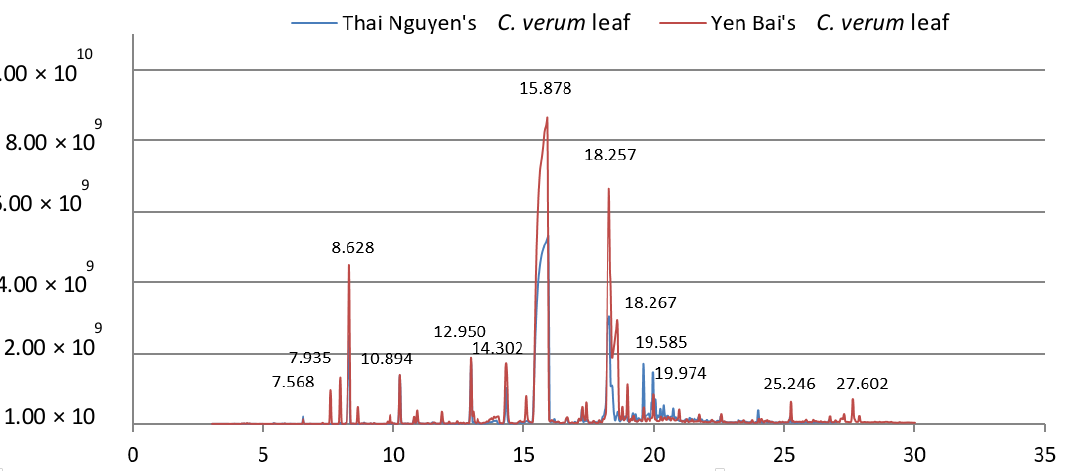
Figure 1. GC-FID spectra of EOs extracted from C. verum leaves cultivated in Thai Nguyen and Yen Bai, with n-hexane used as the extraction solvent.